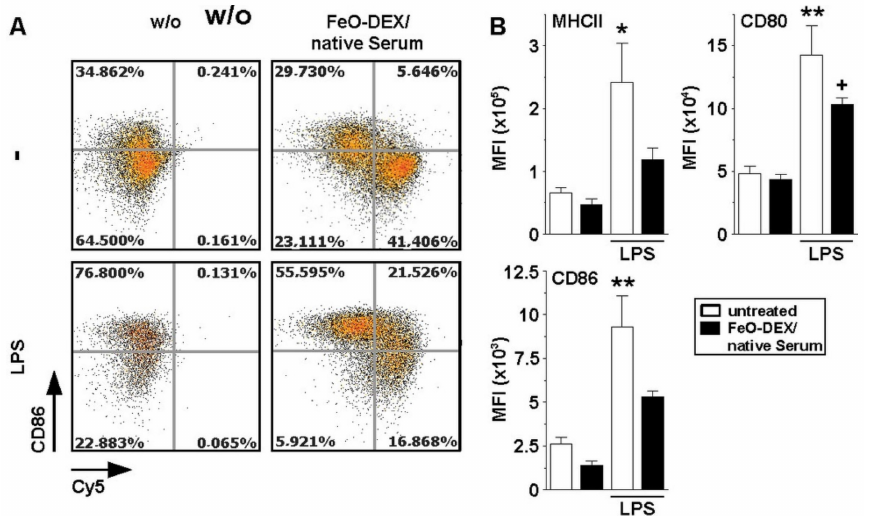
Figure 5. Engagement of CR3 by serum-opsonized FeO-DEX attenuates upregulation of activation markers in response to stimulation. BMDC were incubated with native serum-pre-incubated FeO- DEX. Aliquots were treated with LPS (100 ng/m) applied 1 h later. On the next day, the expression of DC activation markers (MHCII, CD80, CD86) was assessed by FACS analysis. ( A ) Representative FACS plots showing CD86 expression (gating strategy described in Figure S6). ( B ) Quantification of activation marker expression (MFI) of CD11c + BMDC (mean ± SEM of 3 experiments). Statistical differences versus *untreated and + FeO-DEX/native serum are indicated (one-way ANOVA, Tukey’s test). * ,+ p < 0.05, ** p <